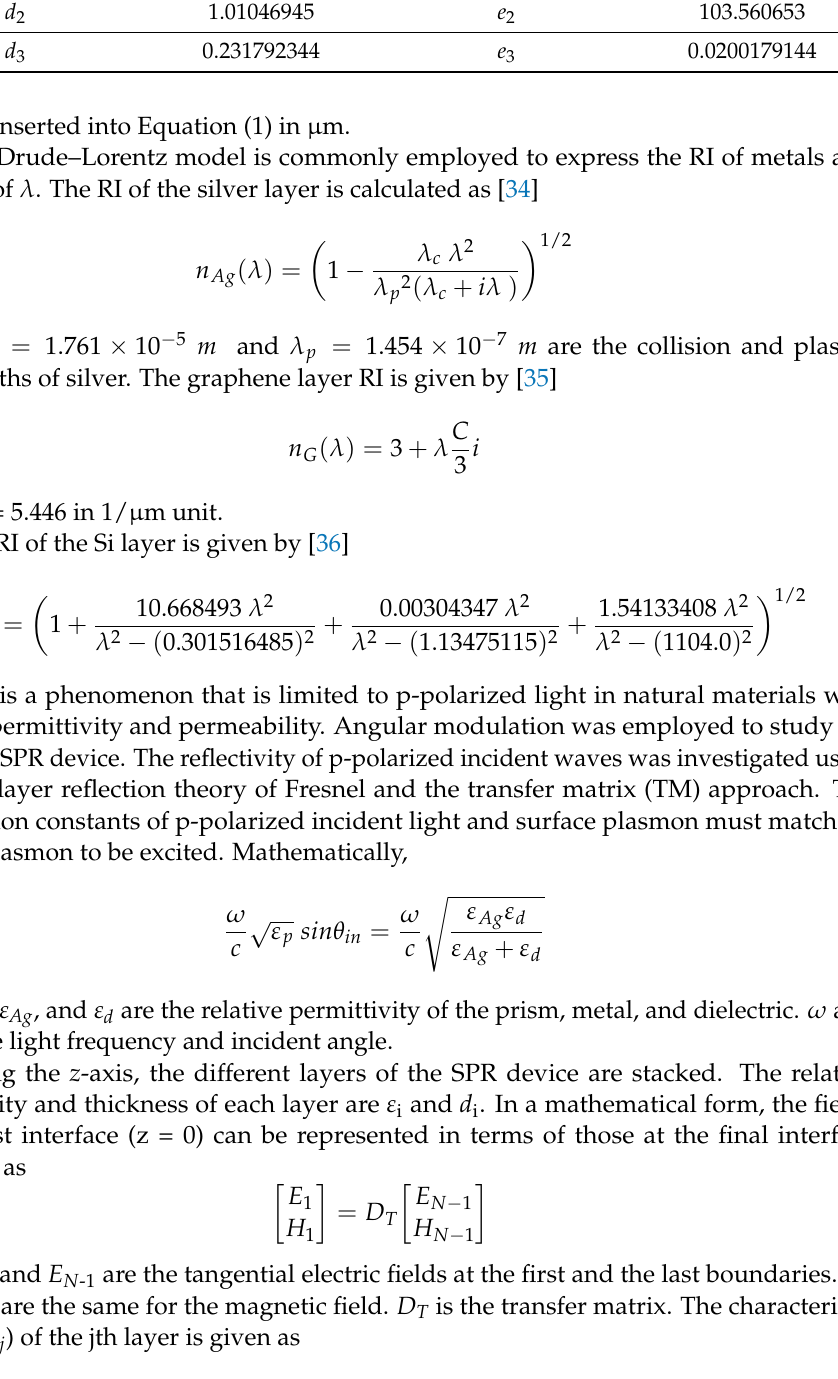
Table 1. The coefficients d i and e i of the BK7 prism. The Coefficient d i Value of d i The Coefficient e i Value of e i d